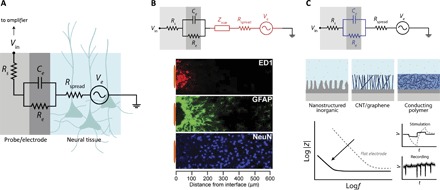
Electrical interface in neural tissue.(A) Equivalent circuit of electrode/tissue interface; in this case, recording is considered [that is, neurons acting as a voltage source (Ve) and use of an amplifier]. However, similar concepts apply for stimulation. (B) Influence of neuroinflammatory reaction (astroglial scar) on local electrical impedance. The neuroinflammatory response adversely affects the signal from the neurons and the spreading resistance and introduces a scar impedance (Zscar) due to the formation of a dense layer of inflammatory cells (ED1), astrocytes (GFAP), and a distancing of neurons (NeuN) from the recording site. Fluorescence image is reproduced, in part, from the study of Biran et al. (31). (C) Influence of enhanced electrode coatings on improving the impedance of the electrode itself. Nanostructuring of traditional electrode materials, use of CNTs/graphene, or conducting polymers (CPs) allow for intimate ion interaction with the electrode, allowing for a marked drop in impedance. The comparison of impedance and resulting stimulation profile for a given biphasic current pulse and recording quality [signal-to-noise ratio (SNR)] is shown for a flat electrode (gray, dotted) and for an electrode with an enhancing coating (black line; for example, CPs).